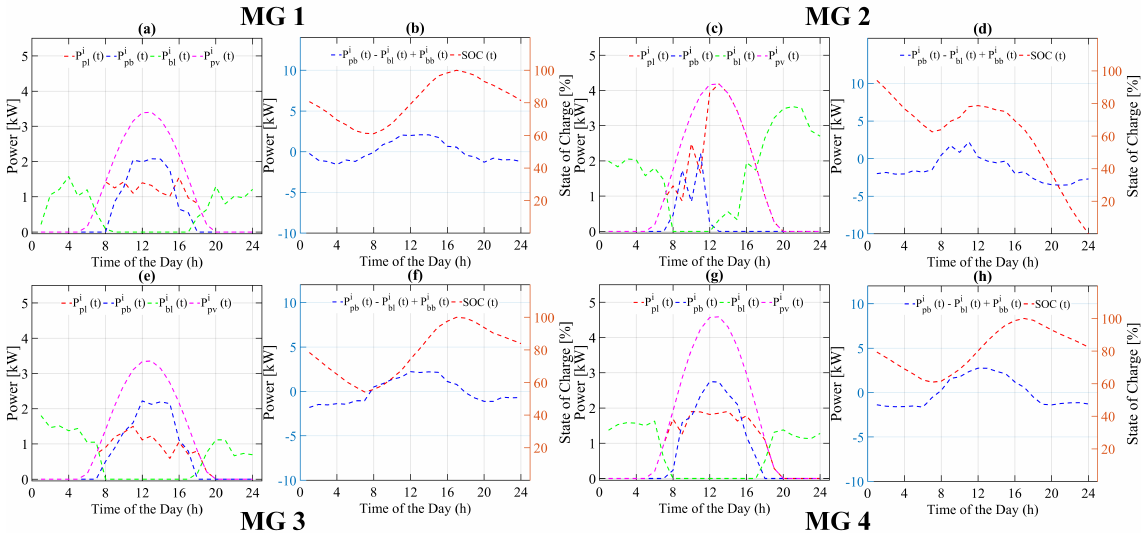
Figure 8. Power flow of various system variable of each microgrid using heuristic state flow based energy management strategy for case B. ( a , c , e , g ) Power flow of PV, battery and Load, ( b , d , f , h ) Battery charging/discharging and state of